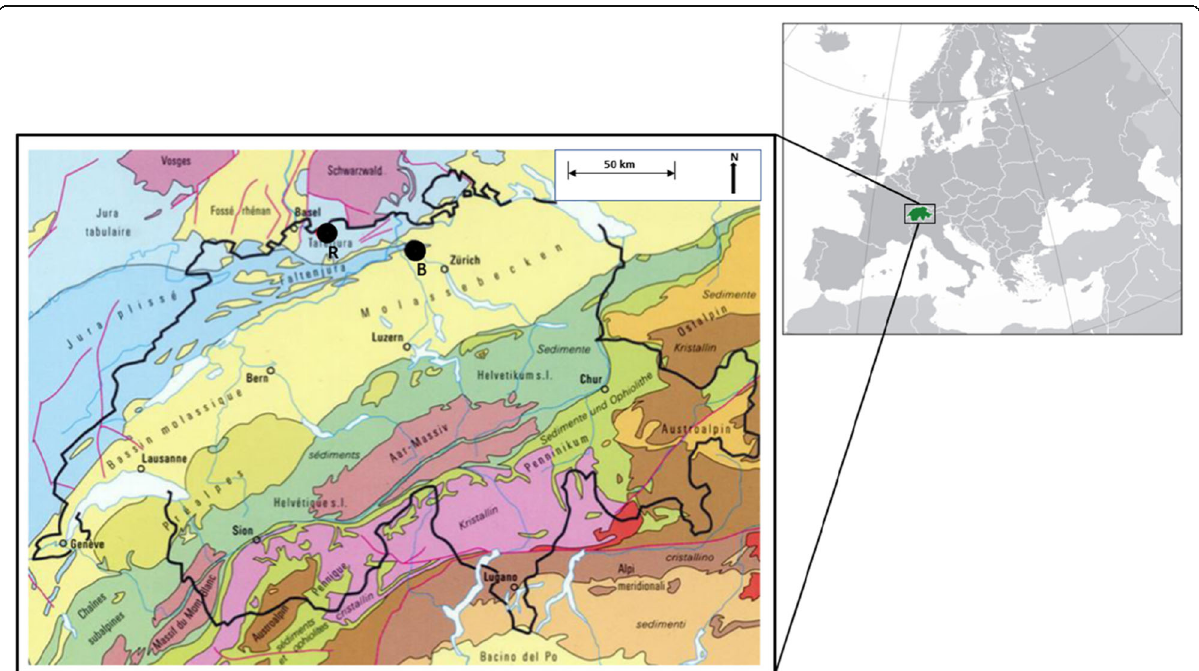
Fig. 2 Geological Map Switzerland and the bordering countries of France and Germany. Switzerland is high-lighted in green on the map of Europe on the right side. The size of the geological map of Switzerland including the four main distinctive units namely, Faltenjura (blue), Molassebecken (yellow), Helvetikum (green) and Kristallin (pink, including the Aar-Massiv, bright-red) is illustrated on the left side. The two Fluorescence monitoring locations Rheinfelden (R) and Baden(B) are presented by bold black dots (modified after swisstopo,